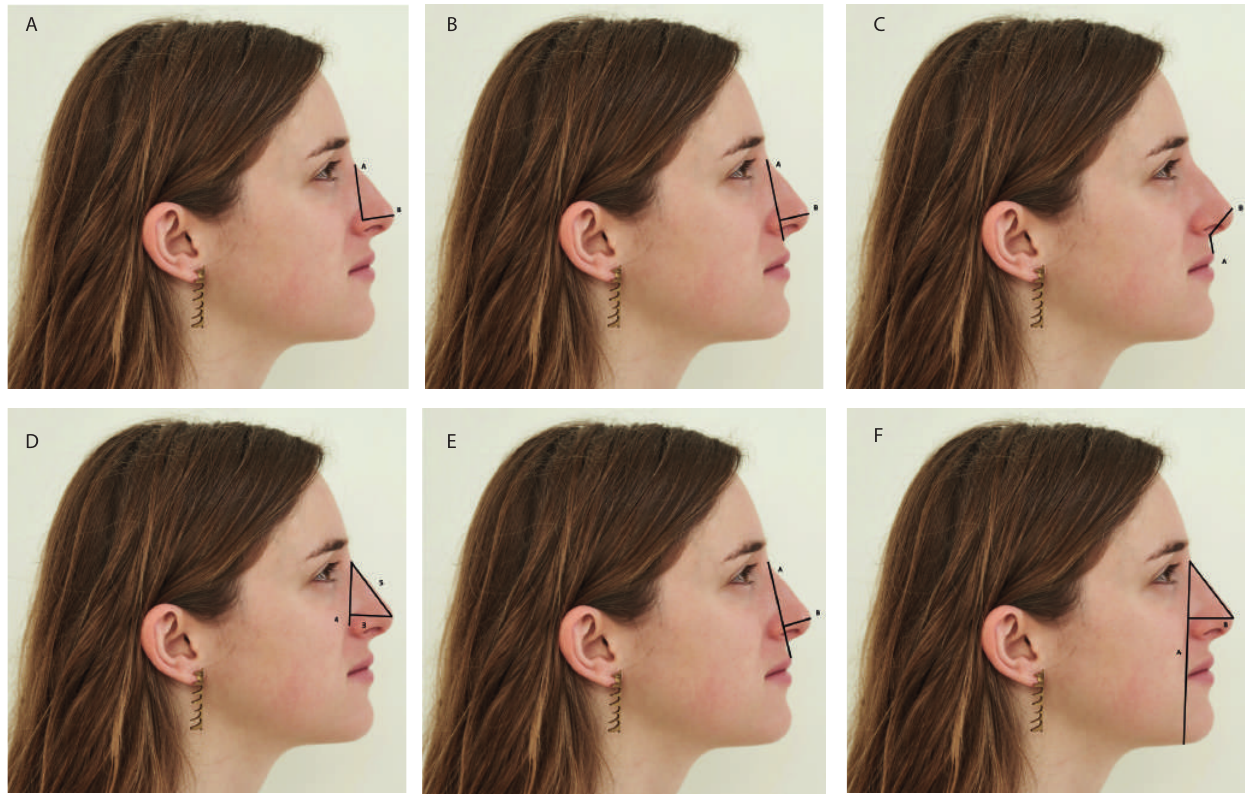
Figure 3. A) Baum's method: ratio of A to B should be 2 : 1. B) Powell and Humphrey's method: ratio of A to B should be 2.8 : 1. C) Simon's